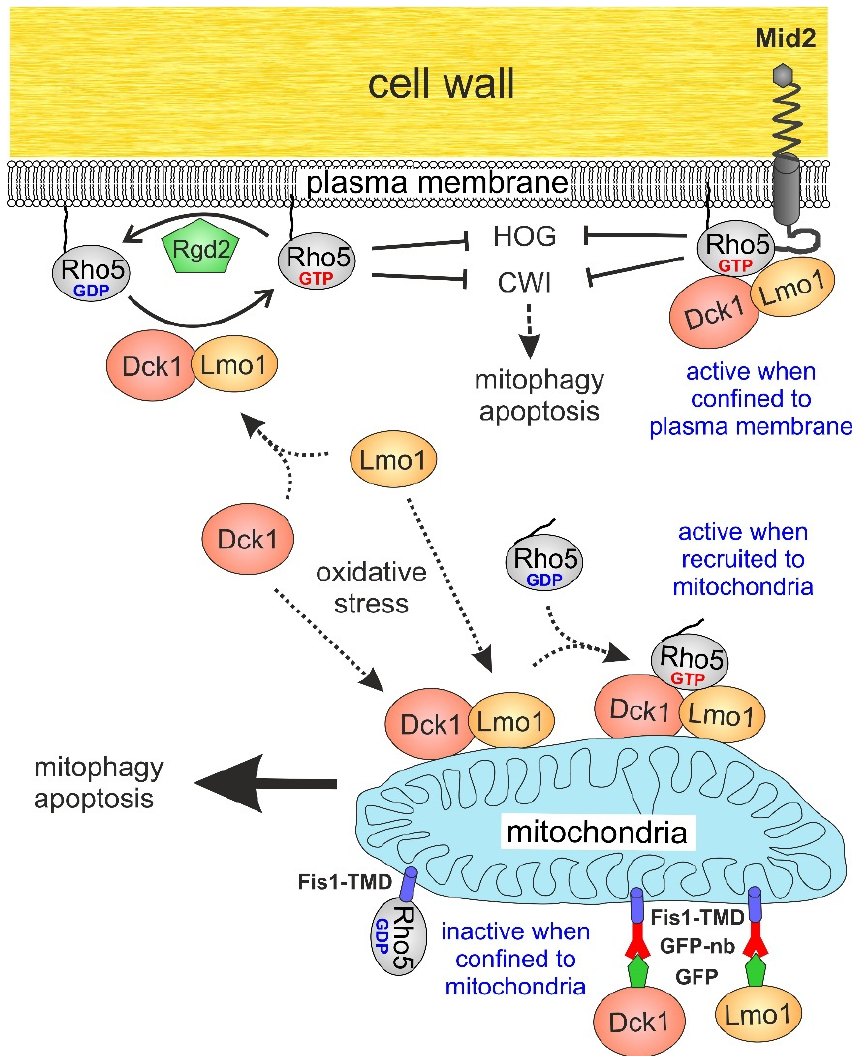
Figure 1. Proposed role of the intracellular distribution of Rho5 and its dimeric GEF Dck1/Lmo1 in the oxidative stress response. Rho5 is inactive in its GDP-bound and active in its GTP-bound state,